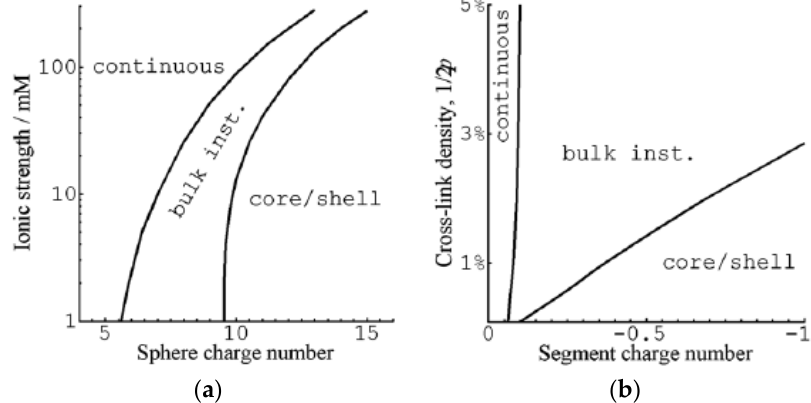
Figure 6. Effect of parameters on the VPT mechanism in systems of spherical gels in large solutions of spherical macroions calculated by G&H. ( a ) Calculated at cross-link density 1% and −1 charge per chain segment; ( b ) at sphere charge +12 and 40 mM salt. [72] Reproduced by permission of the Royal Society of Chemistry.